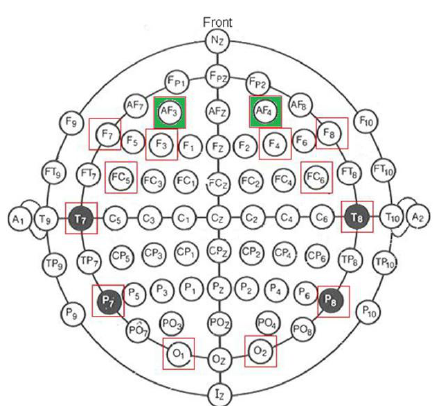
Figure 2. International system 10–20.